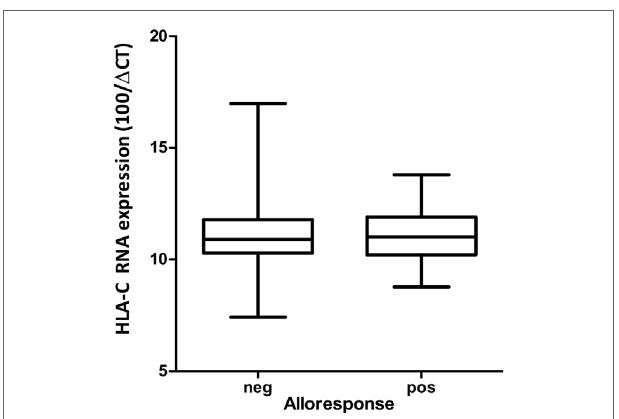
FigUre 2 | Box and whisker plots of hla-c mrna expression quantified by rT-Pcr in stimulator cells at day 0 inducing a negative versus a positive (cutoff = 2% Δ cD137 + cD8 + cells) alloresponse .